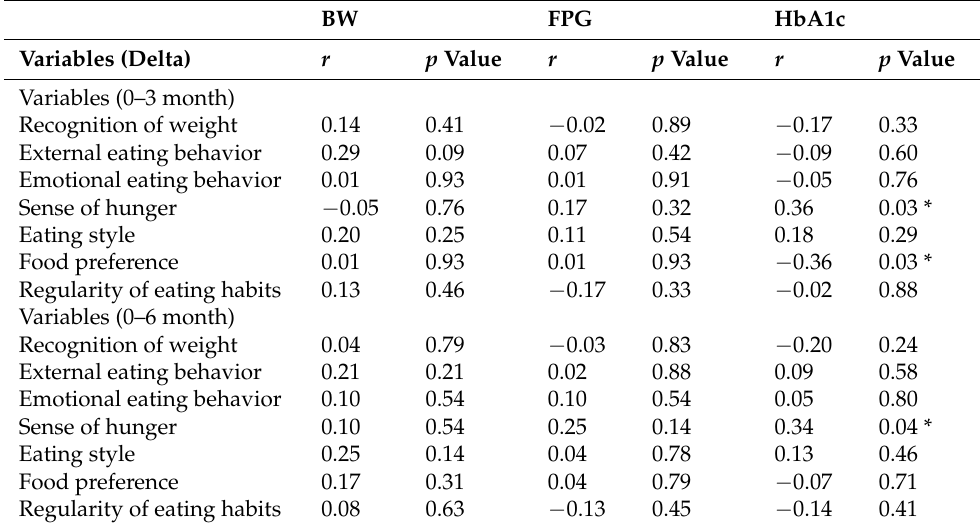
Table 3. Correlation between eating behavior and delta-BW, FPG and HbA1c at 3 and 6 months. BW